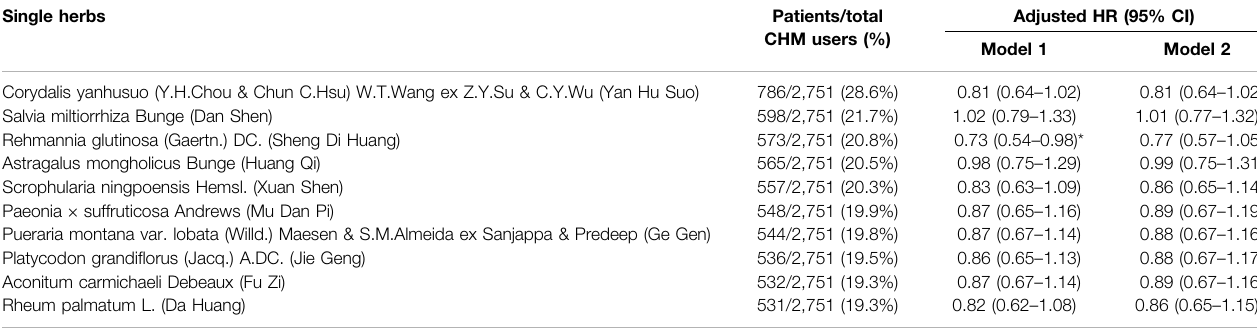
Model 1: adjusted for age, gender, insured amount, and urbanization level. Model 2: adjusted for age, gender, insured amount, urbanization level, comorbidities, and baseline drugs. HR, hazard ratio; CHM, Chinese herbal medicine; CI, con fi dence interval. *p-value < 0.05.